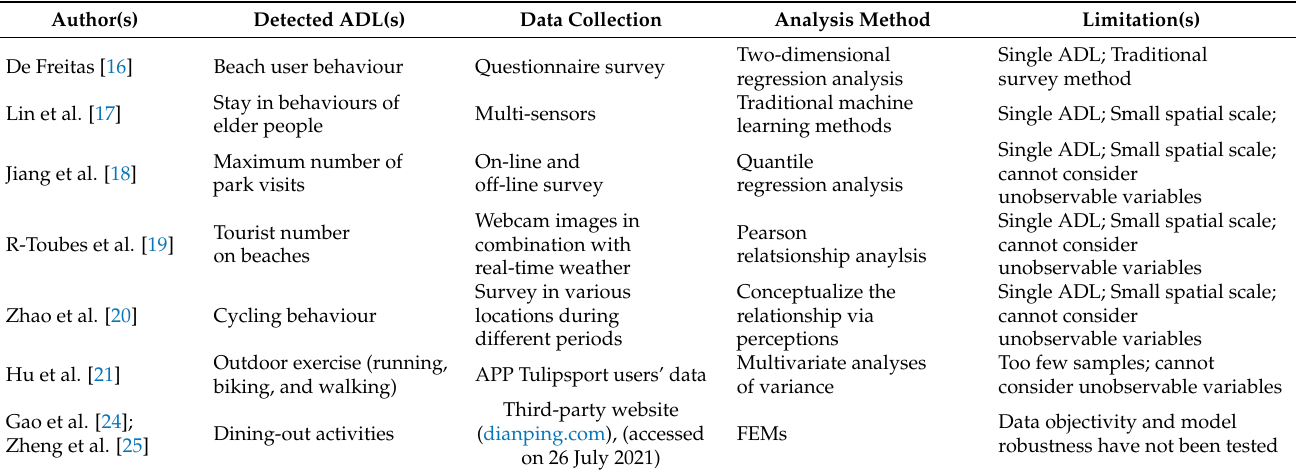
Table 3. A summary of related